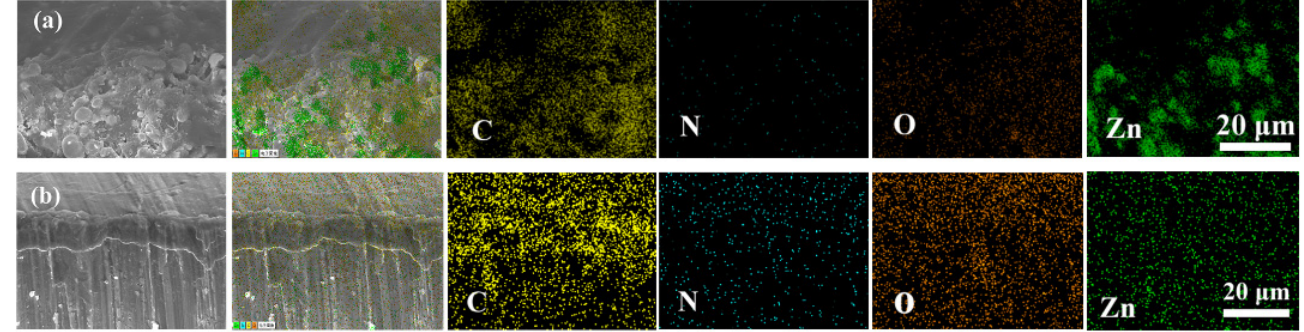
Figure 5. EDX mapping results of ( a ) 80Zn and ( b ) 2PANI-67Zn.